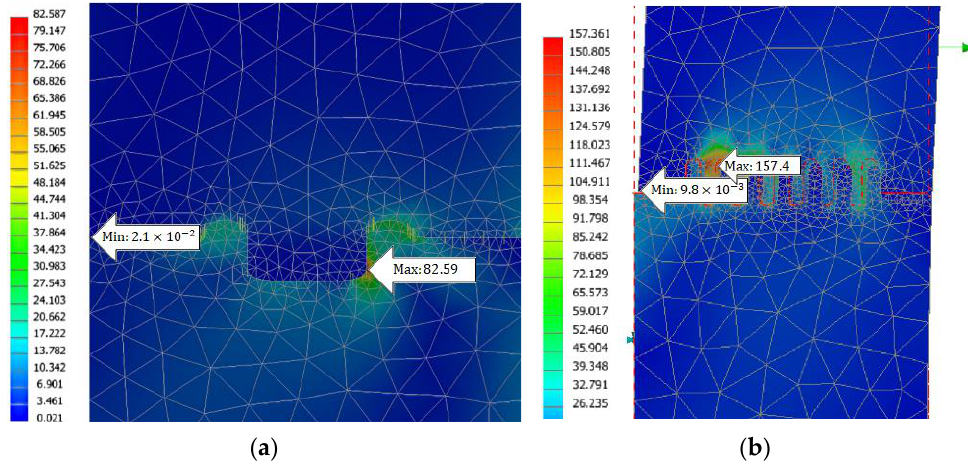
Figure 8. Simulation of two patterns under the same load and constraints; the example with the dot pattern ( a ); and the other with the line pattern ( b ), regarding Von Mises stress (MPa) distribution.